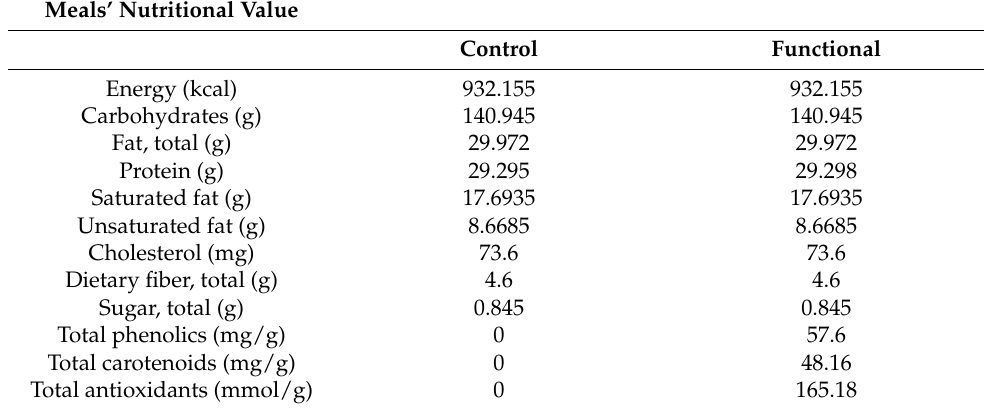
Table 1. Nutritional value of the experimental meals (each